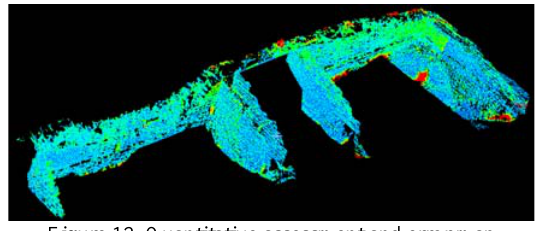
Figure 12. Quantitative assessment and error map